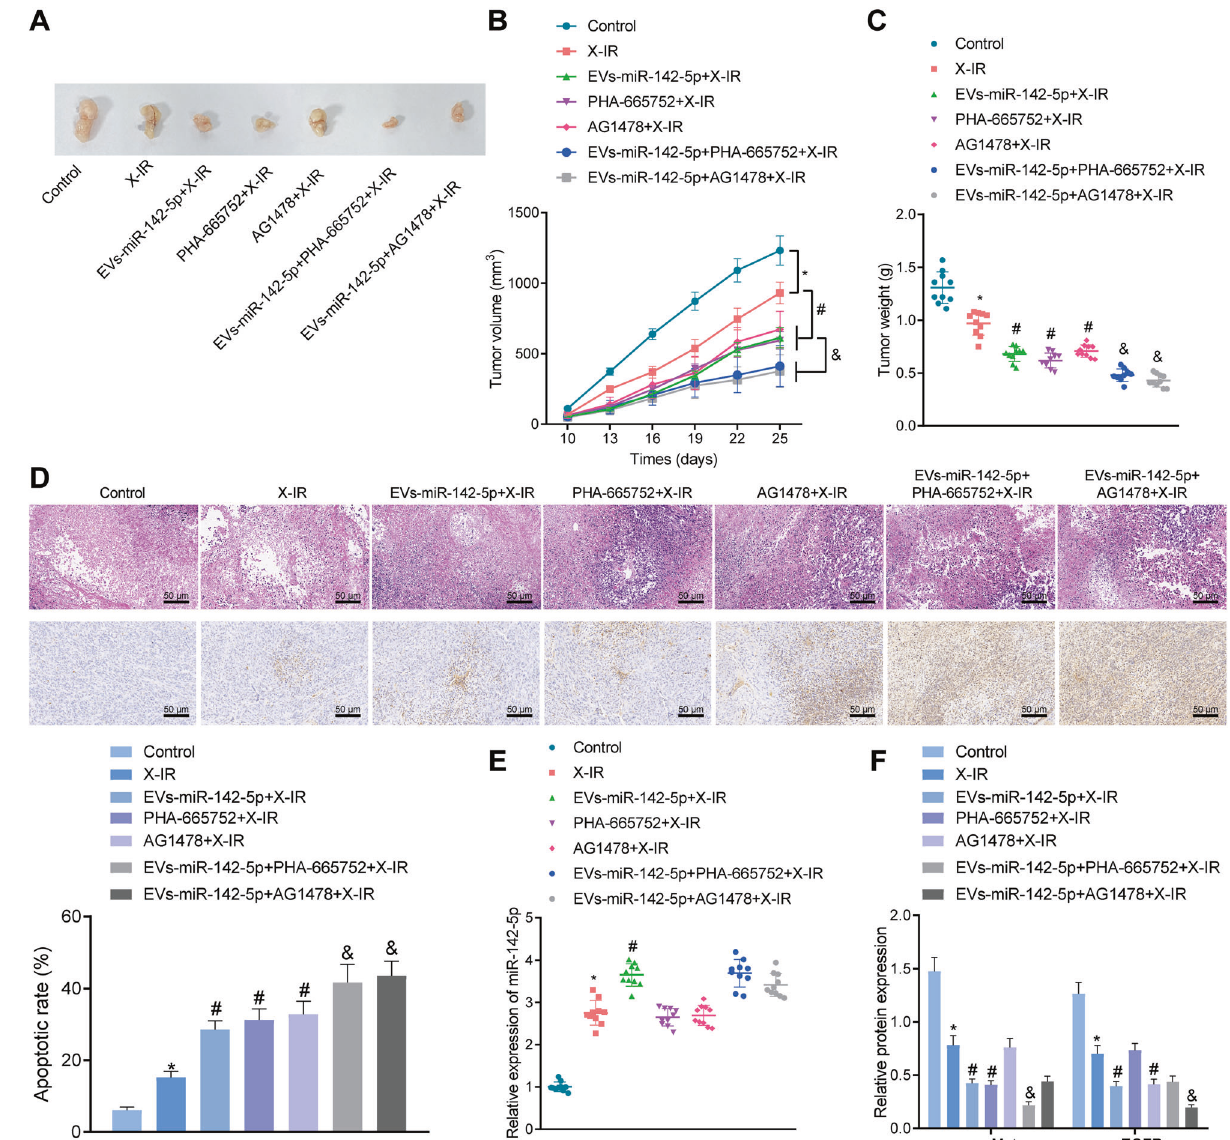
Fig. 7 EVs-miR-142-5p could enhance the radiosensitivity of 5-8FR cells in nude mice by disrupting HGF/c-Met and EGF/EGFR pathways. A Naked eye observation of xenograft tumor in nude mice of each group after 20 days of 6 Gy radiotherapy. B Changes of xenograft tumor volume in nude mice of each group. C Weight changes of xenograft tumor in nude mice. D Representative images of H&E staining and TUNEL staining of tumors of nude mice (scale bars: 50 μ m [left panel] as well as quanti fi cation of TUNEL positive cells [right panel]). E, The expression of miR-142-5p detected by RT-qPCR. F The protein expression of p-c-Met and p-EGFR detected by Western blot. * p < 0.05 vs . control mice; # p < 0.05 vs . X-IR-treated mice; & p < 0.05 vs . mice treated with EVs-miR-142-5p + X-IR. There were ten nude mice in each